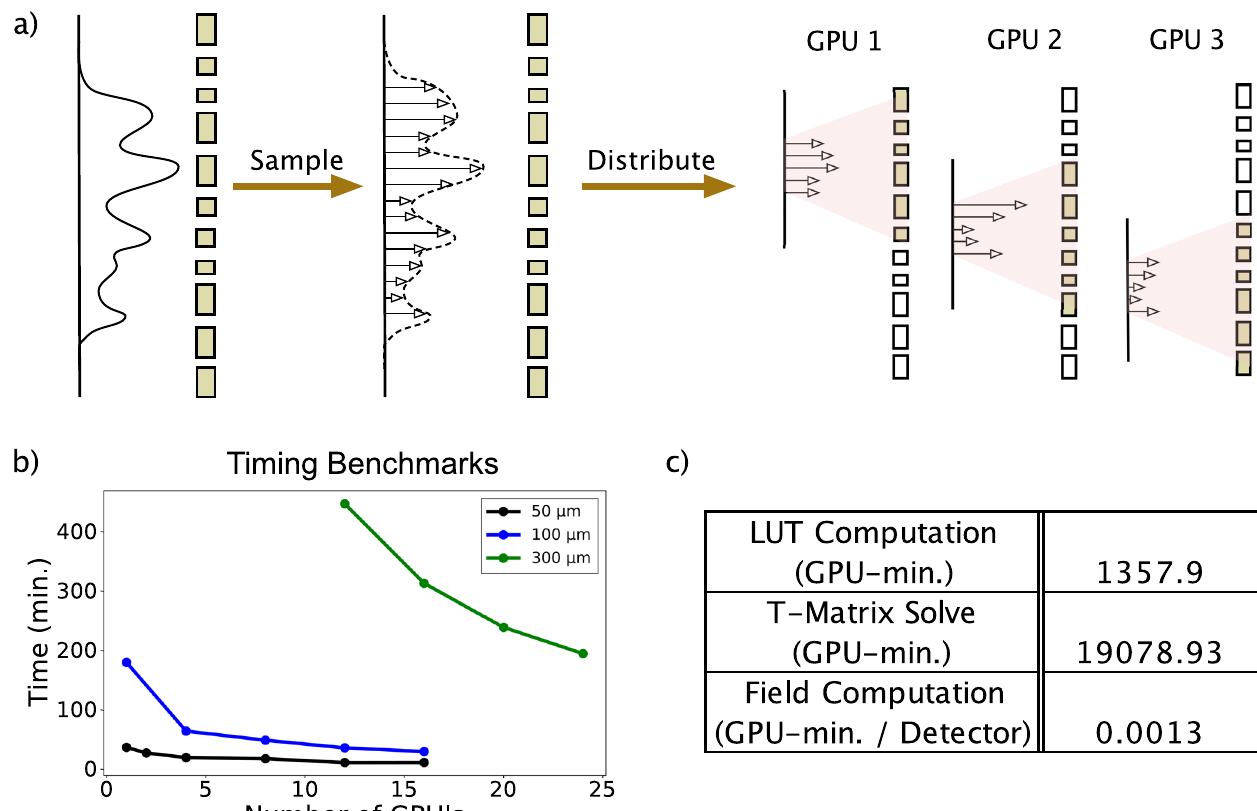
Fig. 2 Low-overhead parallelization scheme for simulation of arbitrarily large metasurfaces. a Schematic of the simulation distribution scheme — the incident fi eld is fi rst sampled and represented as a superposition of jinc sources, and then smaller groups of jinc sources and the locally surrounding metasurface regions are simulated on independent GPUs. b Total simulation time versus number of V100 GPU ’ s used for simulation for a 50 μ m (black), 100 μ m (blue), and 300 μ m (green) metasurface. All metasurfaces have focal length of 25 μ m and are designed from a library of silicon cylinders with height 940 nm, radii range of 50 – 250 nm, lattice period of 1070 nm, air background, and source wavelength of 1550 nm (based on scatterer library from Arbabi et al. 61 ). c Computation time for the key stages of the large-area 1 mm × 1 mm metasurface simulation (metalens with focal length 0.4 mm designed with the same scatterer library used in (b)): top row – computing the Look-Up Tables (LUT) used to ef fi ciently perform T-matrix simulation (Supplementary Note 1); middle row – computing the T-matrices (Supplementary Note 1.b) and solving the resulting linear system of equations for the scattered fi eld coef fi cients (Supplementary Note 1.c, Supplementary Eq. 23); bottom row – computing the E and H fi elds from the scattered fi eld coef fi cients for each desired detector point (Supplementary Note 1.c, Supplementary Eq.